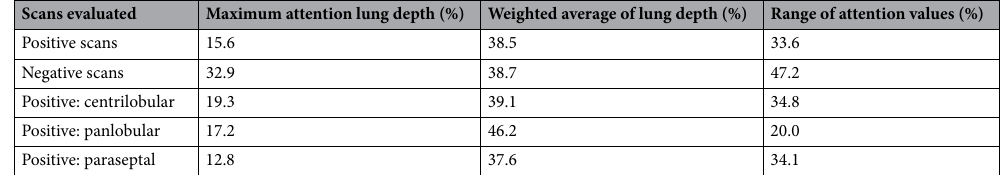
Table 3. Quantitative attention weights from Fig. 2. Recall, influence is quantified by three metrics: (1) depth maximum attention of fit curve, (2) weighted average of slice depths weighted by attention, and (3) range of fit curve attention